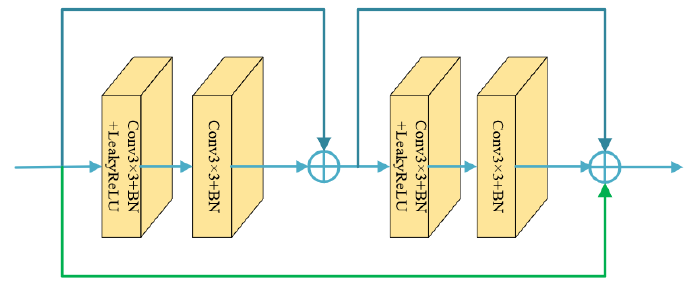
Figure 3. The structure of the residual convolution block.